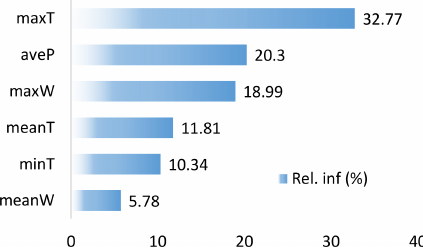
Figure 3. Relative influence of variables predicting a snow disaster day. Blue bars are relative importance of each factor and the sum of all relative importance fractions is